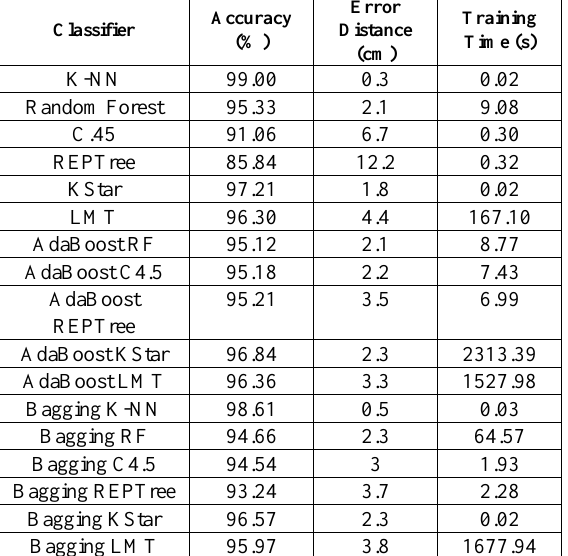
Table 2. Performance of classifiers.